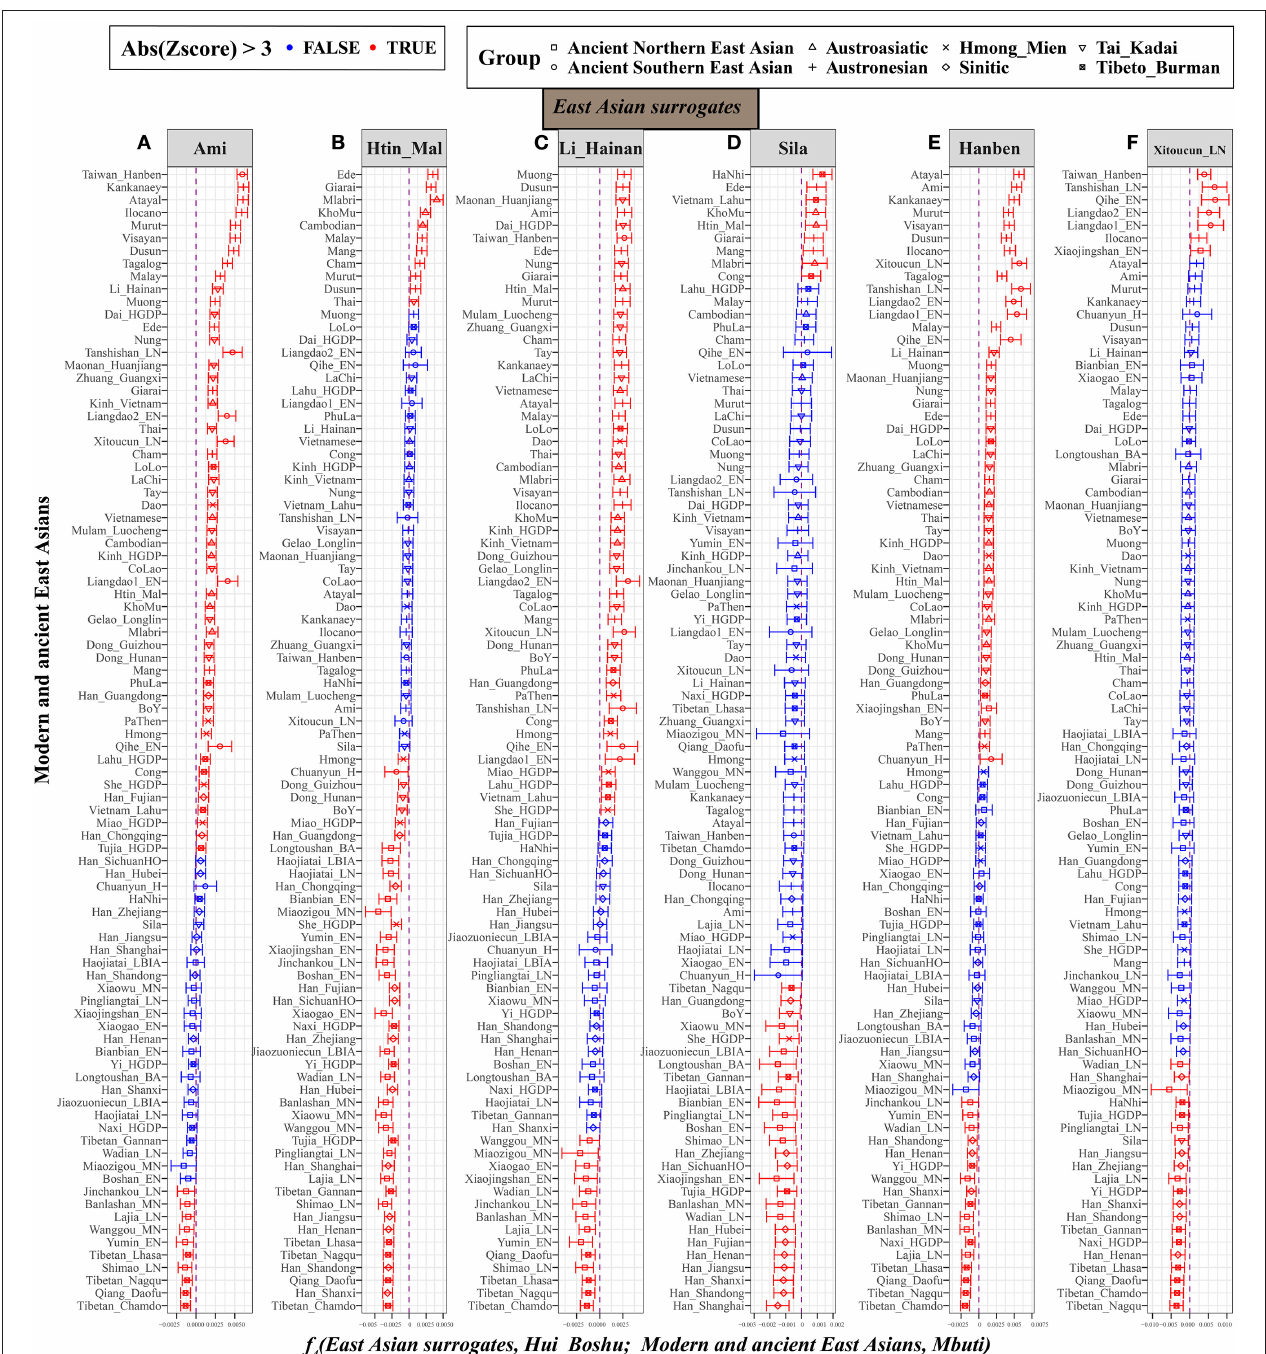
FIGURE 4 | Higher gene flow in Hui from Sino-Tibetan speakers and ancient Northern East Asian in Hui than other East Asian populations inferred from f 4 (East Asian surrogates, Hui_Boshu; East Asians, Mbuti) . This type of affinity- f 4 -statistics was used to explore the genetic continuity and admixture between potential ancestral sources and Boshu Hui based on the merged Human Origin dataset. East Asians were listed in the left parts of the bar plots, and we used Ami (A) , Htin_Mal (B) , Li_Hainan (C) , Sila (D) , Hanben_Taiwan (E) , and Xitoucun_LN (F) as the surrogates of our focused East Asians. All Y-axis-related populations were sorted via the Z-scores. The bar denotes the three times of the standard errors. The red color denotes East Asians (left population lists) sharing more derived alleles with Boshu Hui compared with our used East Asian surrogates. The green color denotes the surrogate population formed with one clade with Hui people. Statistically significant f -statistics were marked as red